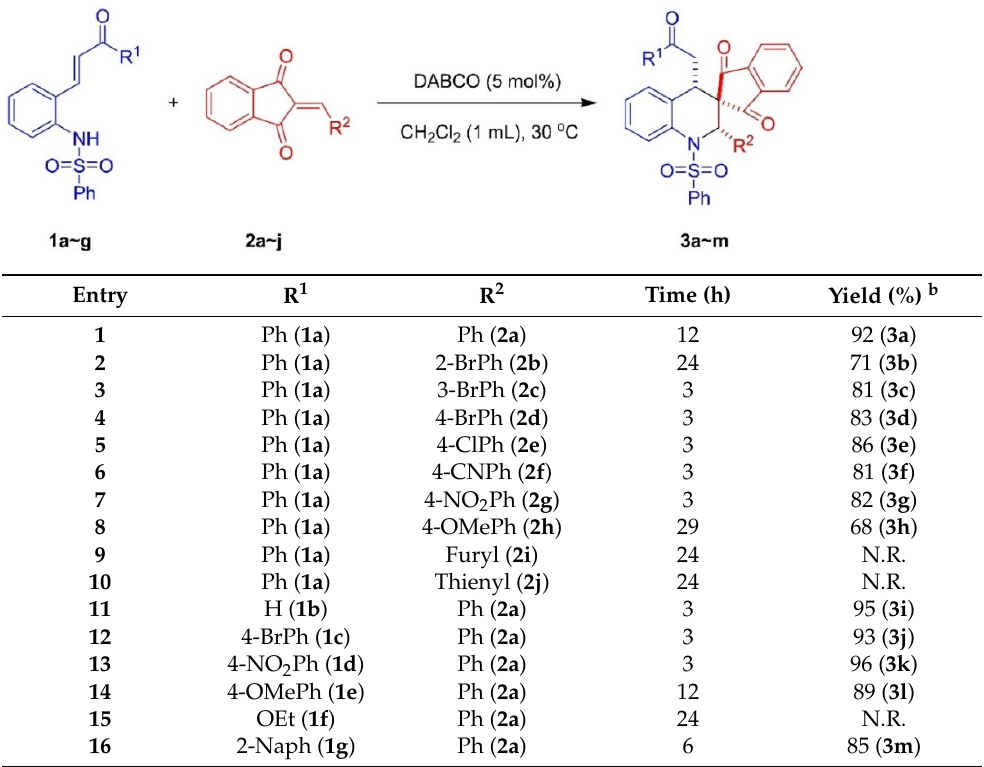
Table 2. Effect of different substituents on reaction rate a .